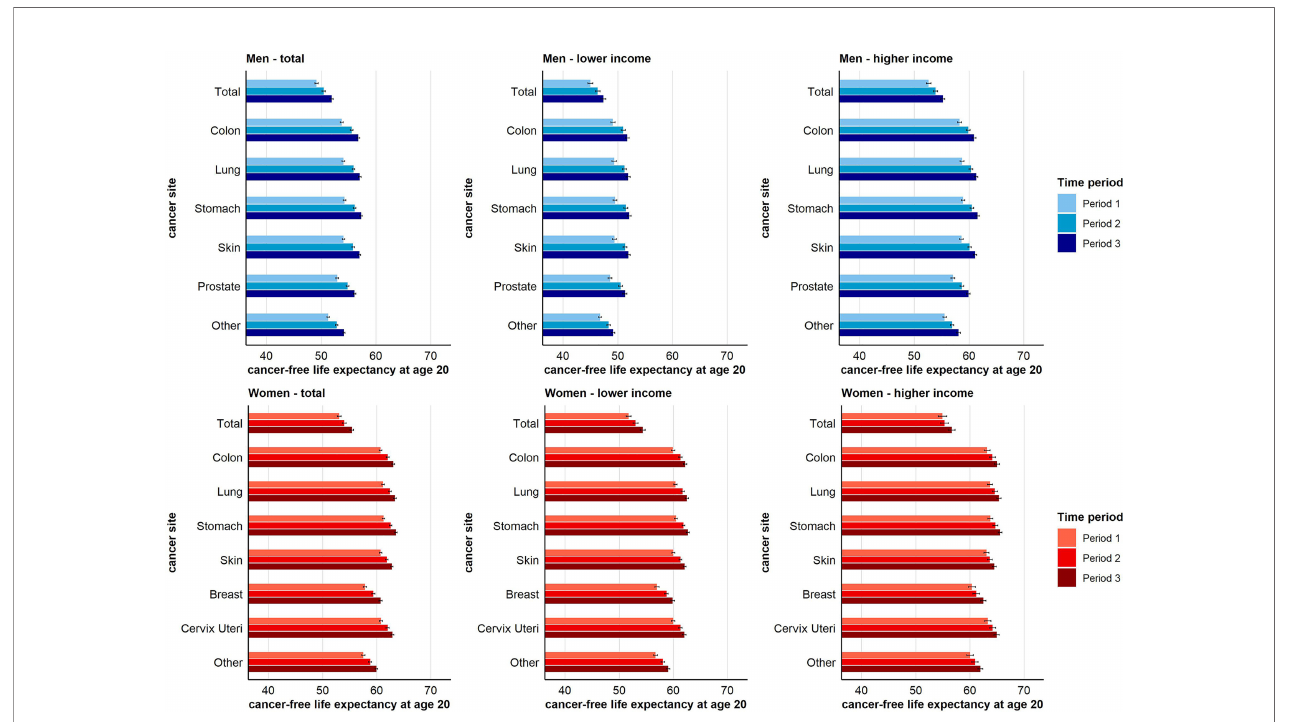
FIGURE 3 | Time trend in cancer-free life expectancy for total and site-speci fi c cancer by sex and income group at age 20 (955-CI).